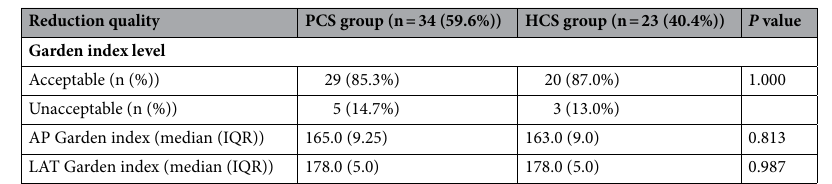
Table 3. Reduction quality in different internal fixation groups. IQR stands for interquartile range.